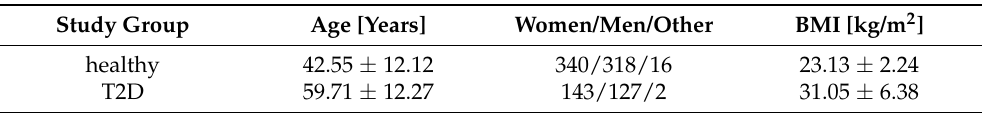
Table 1. Distribution of the age, sex, and body mass index (BMI) parameters for the healthy and type 2 diabetes mellitus (T2D)